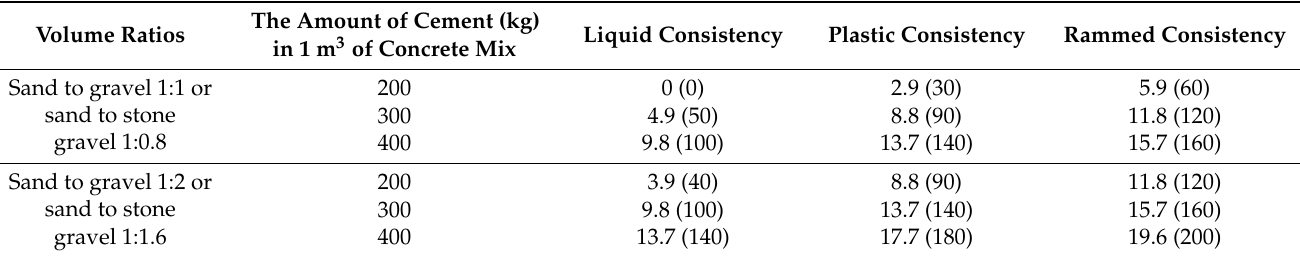
Table 3. Concrete strength in MPa (kg/cm 2 ) depending on the amount of cement in 1 m 3 of ready concrete on the degree of liquidity and the volume ratio of aggregate (according to guidelines given in [37]). Volume